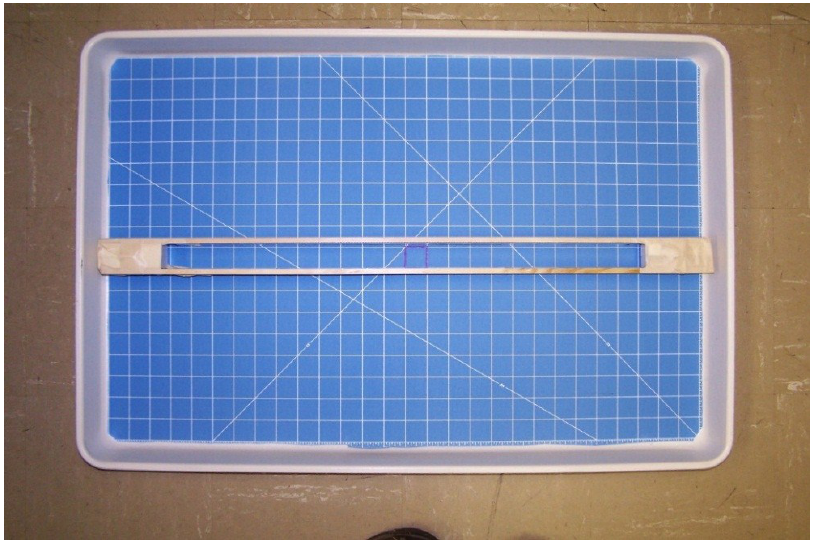
Figure 1. One-dimensional arena set-up. Bed bugs were released inside the marked square.